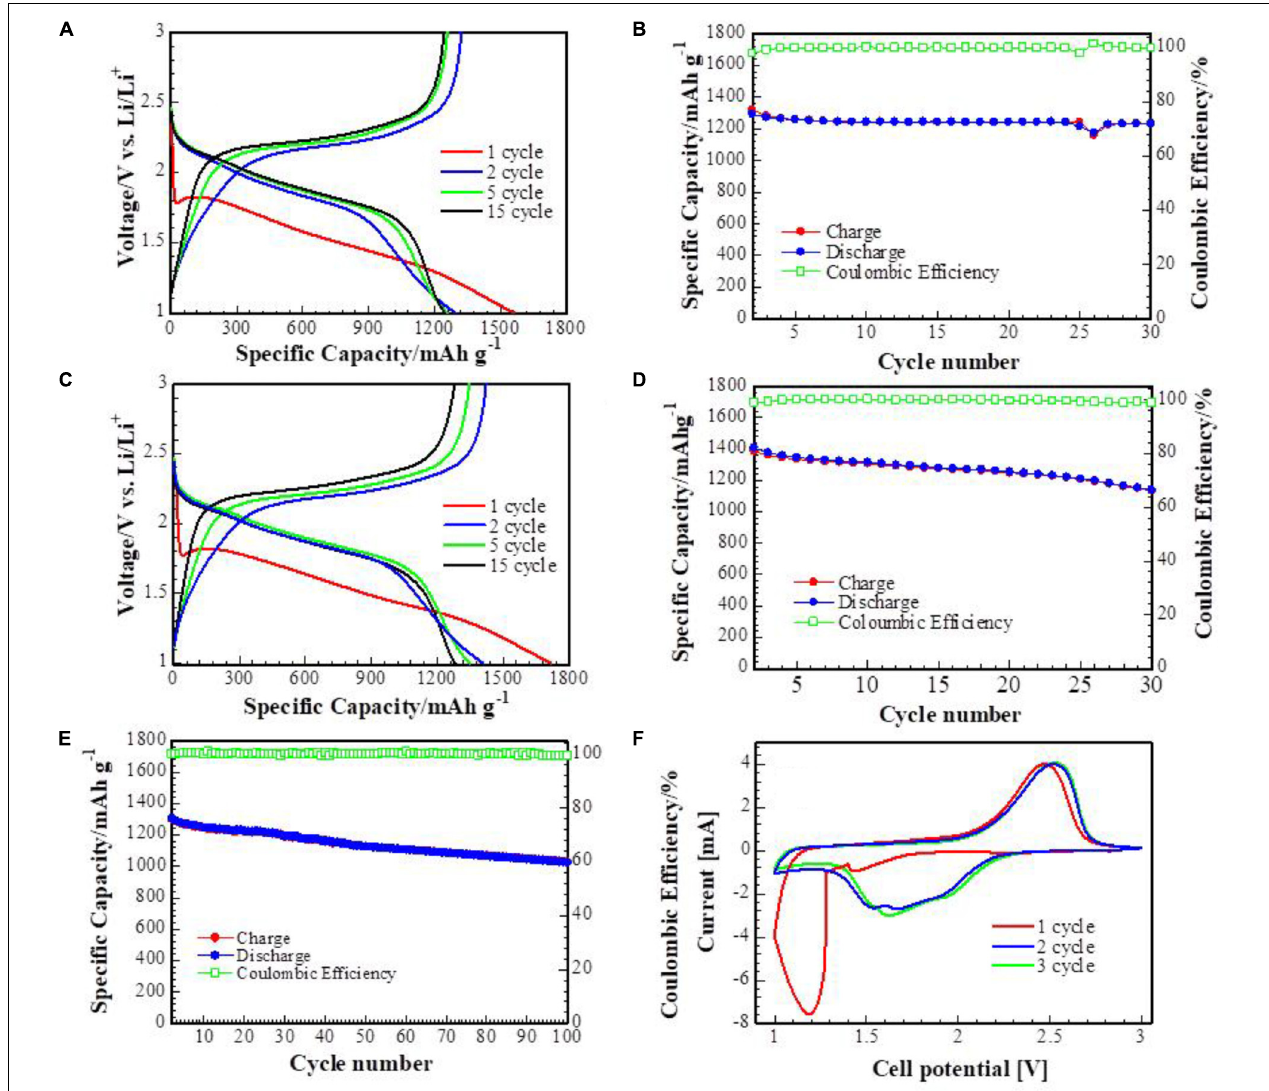
FIGURE 5 | Potential profiles and cycle performance of S/DPAN/CNT composite cathodes. (A,B) cathodes on Al current collector. (C,D) cathodes on CFP current collector at 0.1C, (E) longer cycling performance of S/DPAN/CNT on CFP current collector (F) CV profiles (0.1 mV s − 1 ) of the cells with S/DPAN/CNT